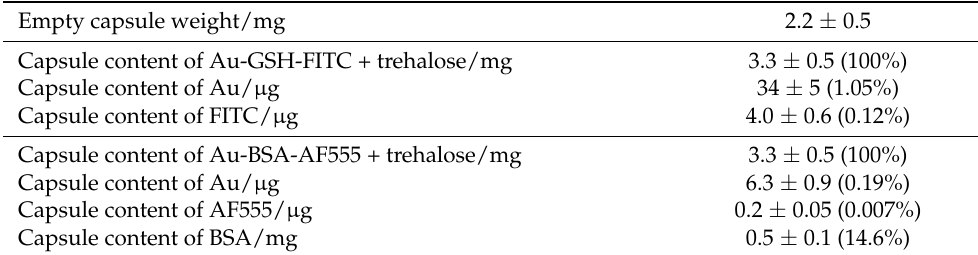
Table 1. Characterization of gelatin capsules, loaded with either Au-GSH nanoparticles or Au- BSA nanoclusters. Given are weight percentages with respect to the total weights of nanocarriers, including trehalose ( ± indicates the standard